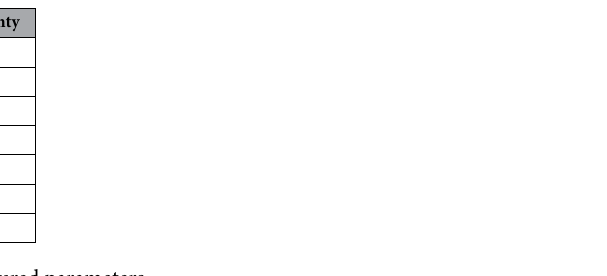
Table 5. Uncertainty analysis of the measured